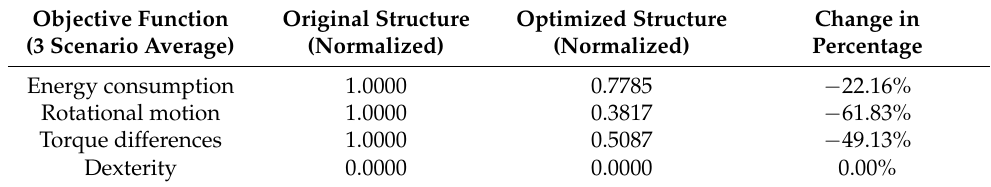
Table 8. Objective results before and after